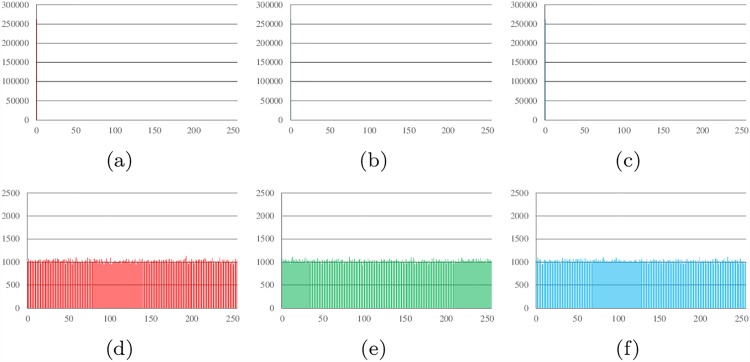
Histogram analysis results of all-zero image.(a) Histogram of red channel of all-zero; (b) Histogram of green channel of all-zero; (c) Histogram of blue channel of all-zero; (d) Histogram of red channel of cipher; (e)Histogram of green channel of cipher (f)Histogram of blue channel of cipher.